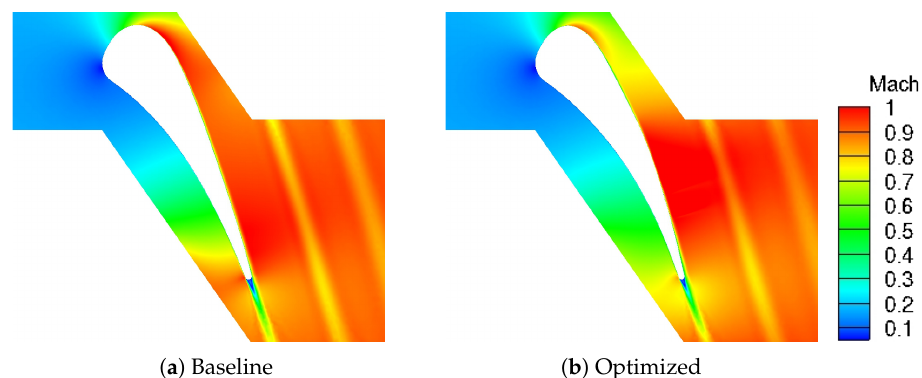
Figure 8. Computed Mach number fields for the baseline and optimized configurations.